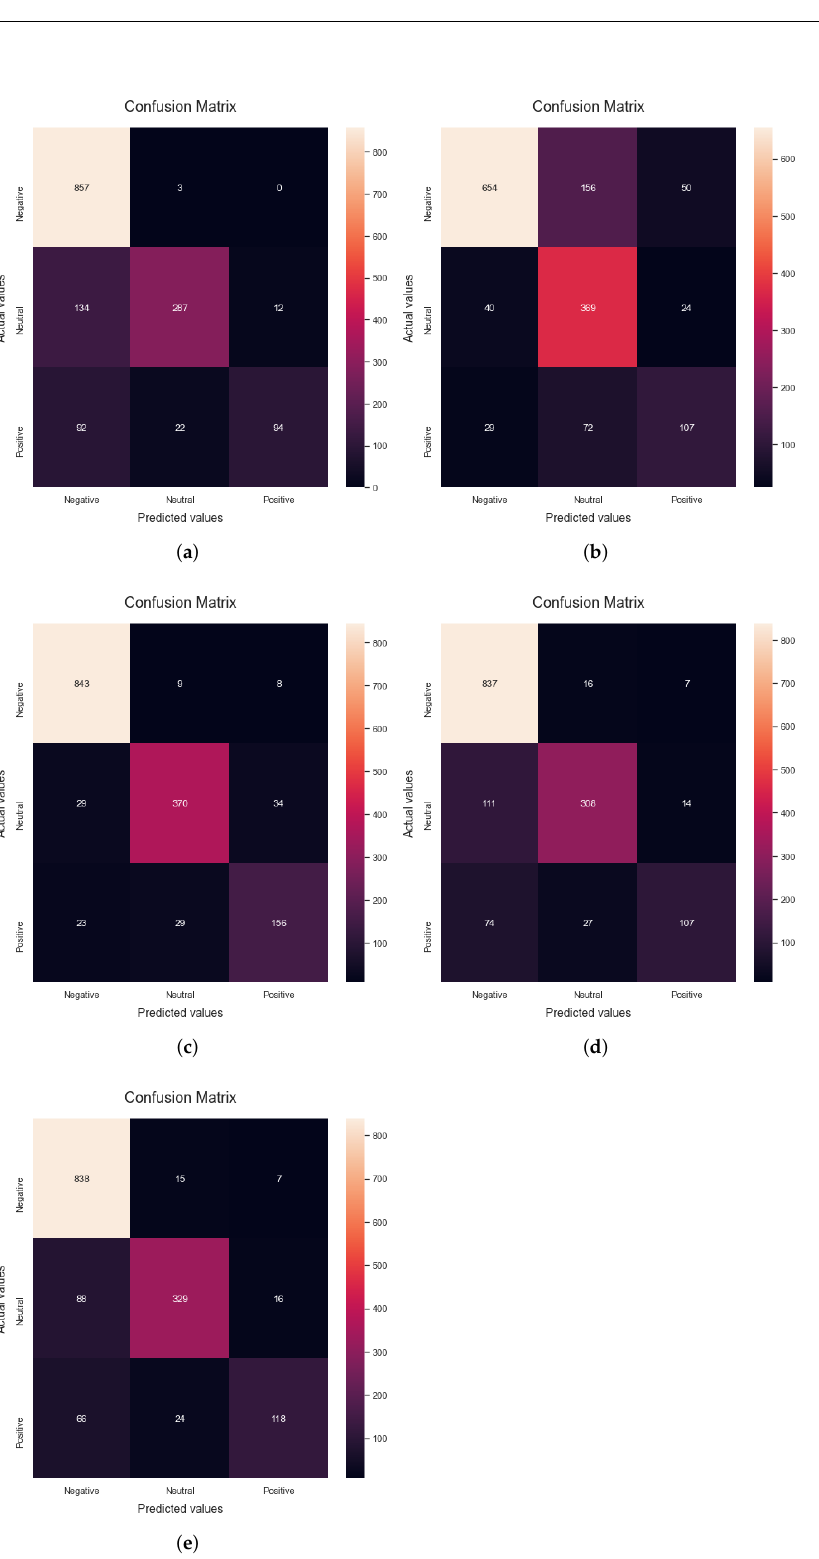
Figure 4. Confusion matrix for AstraZeneca Dataset: ( a ) using Random Forest ( b ) Naive Bayes ( c ) Decision Tree ( d ) Logistic Regression ( e )